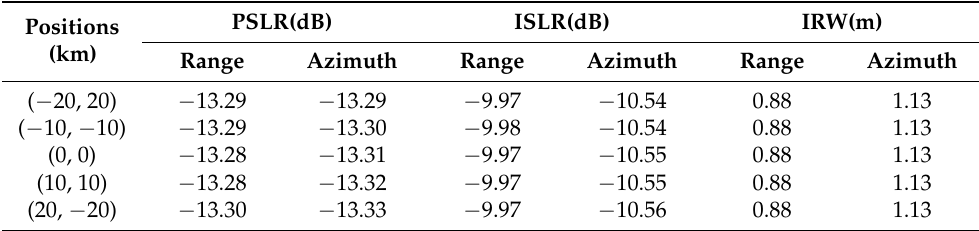
Figure 20. Focusing results with the range model proposed in this paper for 2000 s integration time at perigee. Table 4. Evaluation parameters of point targets by the imaging method proposed in this paper.